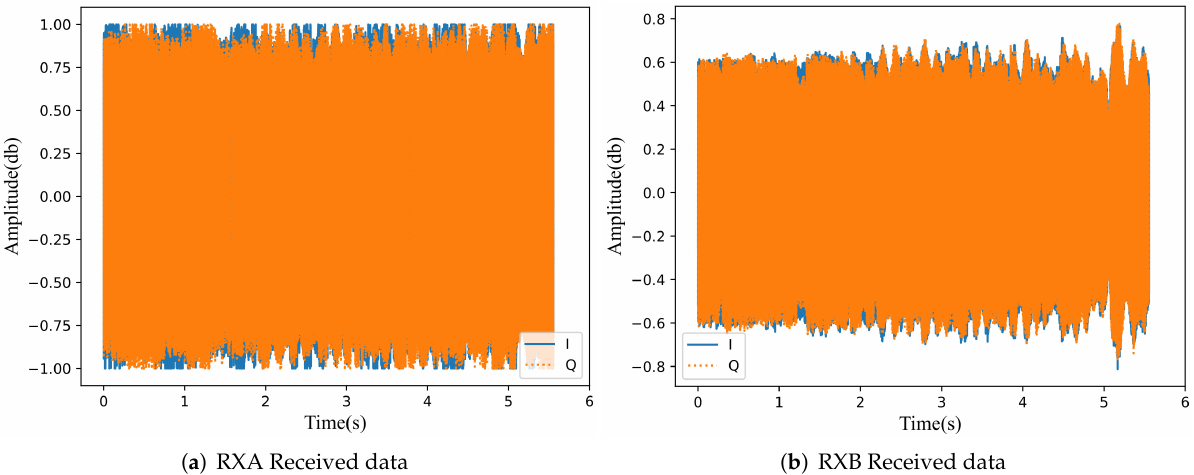
Figure 3. The signal amplitude received by the two receiving